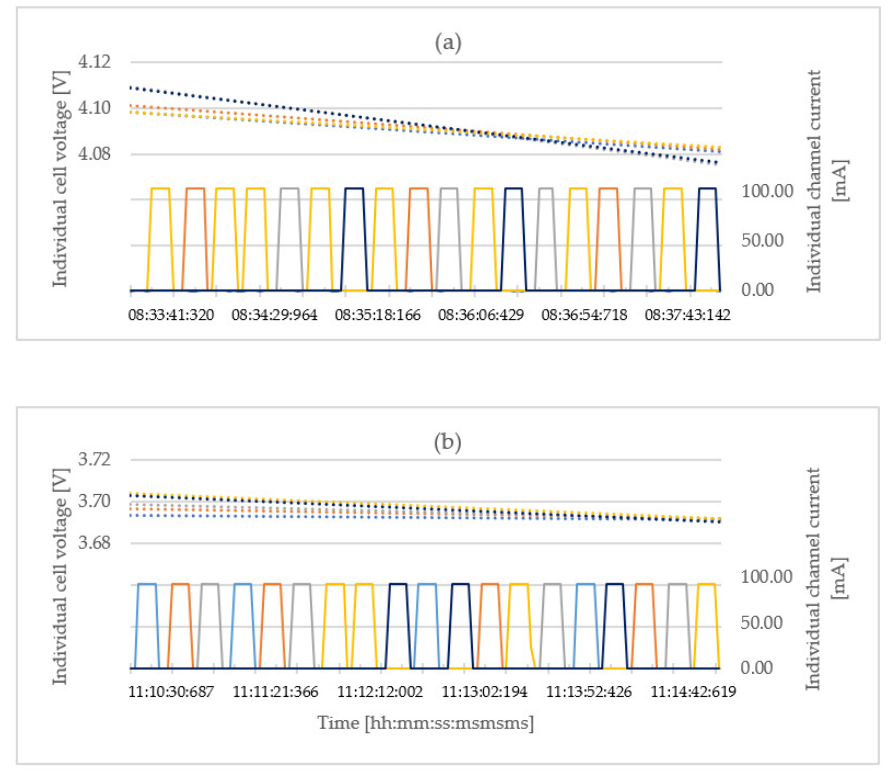
Figure 16. Initial ( a ) and final ( b ) battery ‐ cell voltage (trendlines) and balancing channels current oscillograms in the de ‐ balance system configuration.